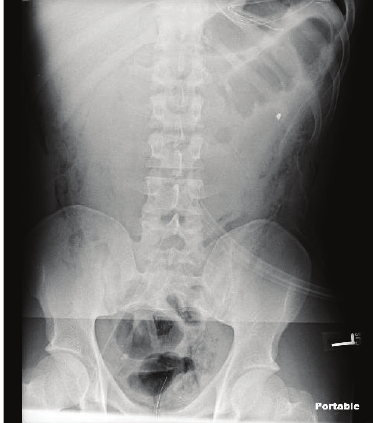
Figure 2: Post-op abdomen X-ray showing bullet fragment in left upper quadrant.